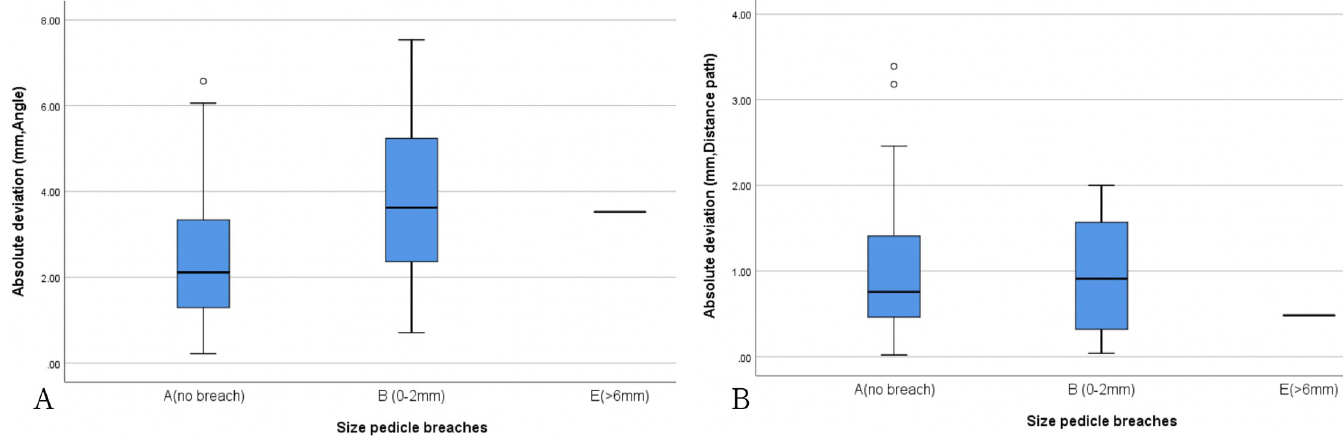
Fig 7. Boxplot showing correlations between actual pedicle screw positions and preoperative planning paths for different groups.